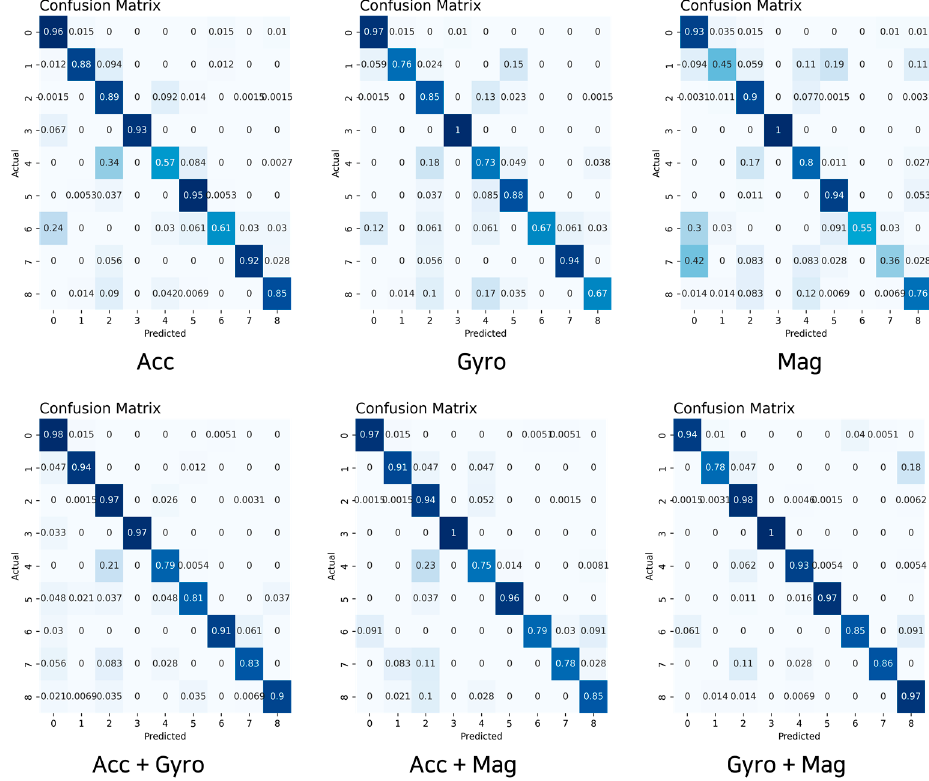
Figure 11. Behavioral prediction confusion matrix using three- and six-axis data.